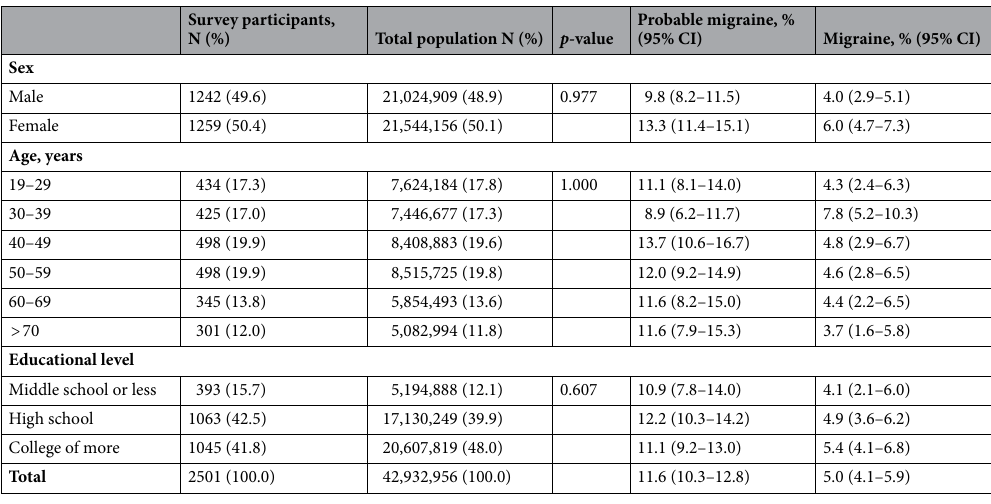
Table 1. Sociodemographic distribution of survey participants and participants identified as having probable migraine and migraine in the 2018 survey as proportions of the overall population. CI: confidence